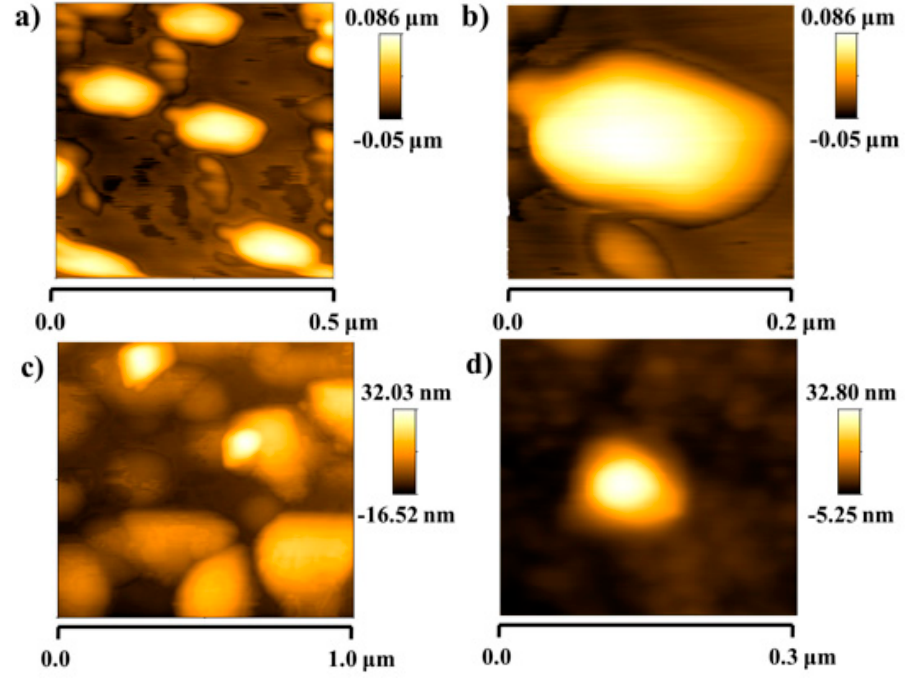
Figure 18. ( a , b ) AFM images in tapping mode for the LbL-E coatings in order to corroborate the presence of nanorods of an approximated size of 200 nm; ( c , d ) AFM images in tapping mode for the LbL-E coatings in order to corroborate the presence of both spherical nanoparticles and particles of higher size (clusters).